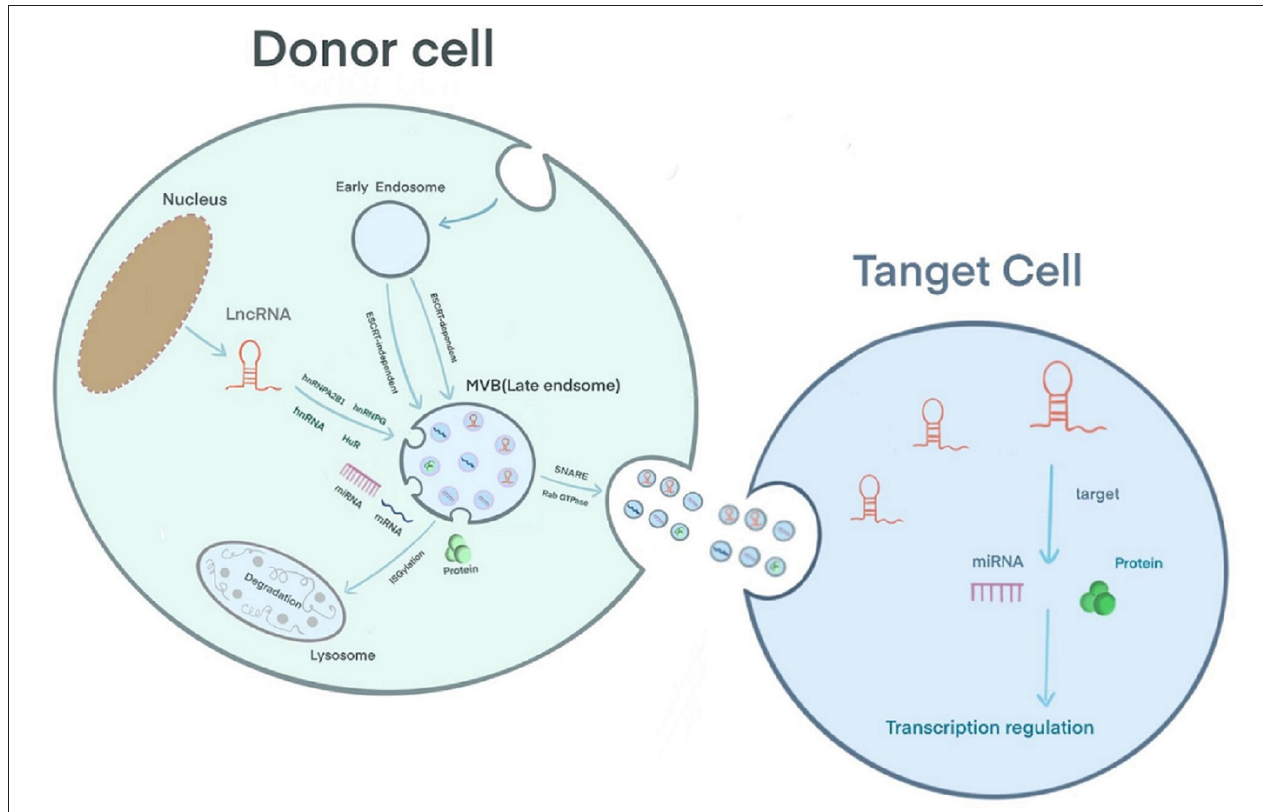
FIGURE 1 | Exosome biology and the sorting and action mechanism of exosomal